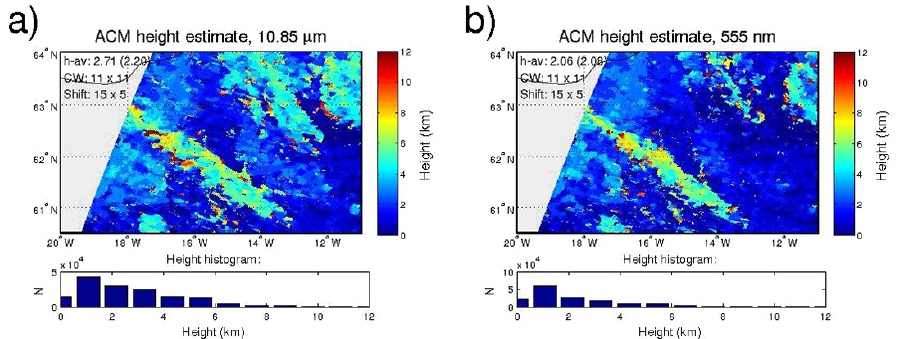
Figure 3. Effect of wavelength on a full-scene height retrieval. The height maps show the ACM single-pixel height estimates (kma.s.l.) for an Eyjafjallajökull ash plume and its surroundings on 16 May 2010, obtained at two wavelengths, namely 10.85µm and 555nm. The height histograms below the maps show number of pixels within each height bin. See text for details.